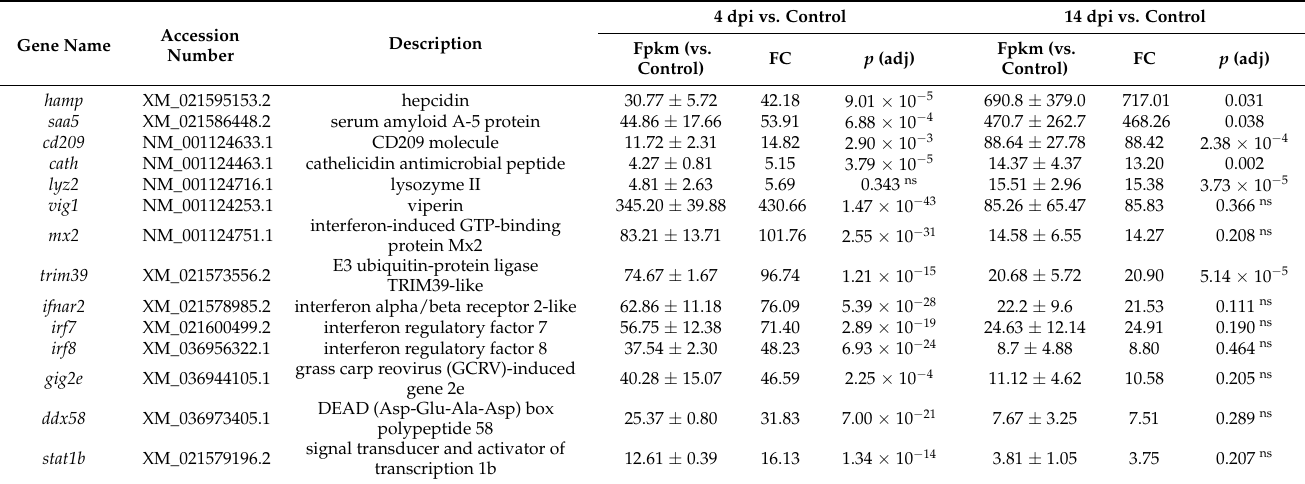
Table 1. Expression changes of 20 representative immune-related